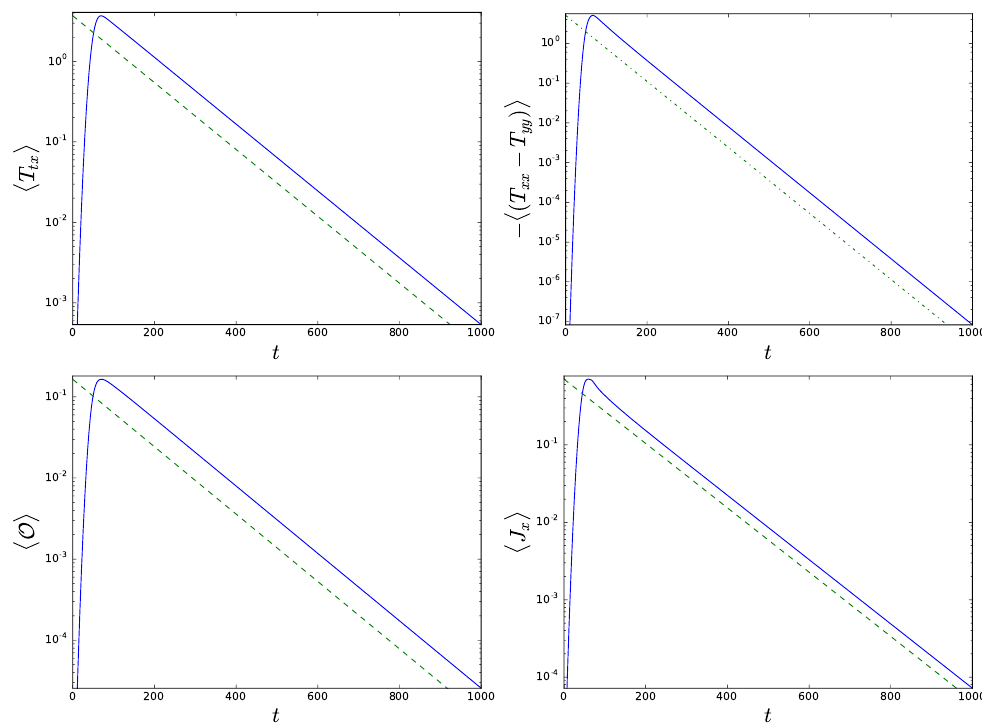
Figure 5 . Logarithmic plots of expectation values h T tx i ; h ( T xx (cid:0) T yy ) i ; hOi ; and h J x i . The dashed line corresponds to e (cid:0) ! i t while the dot-dashed line corresponds to e (cid:0) 2 ! i t . All one point functions, except for the energy density, seem to have a relaxation time far longer than the time scale of the pump (cid:12)eld. Inspecting the logarithmic plots in (cid:12)gure 5 one (cid:12)nds that they decay towards equilibrium exponentially in time. The rates of